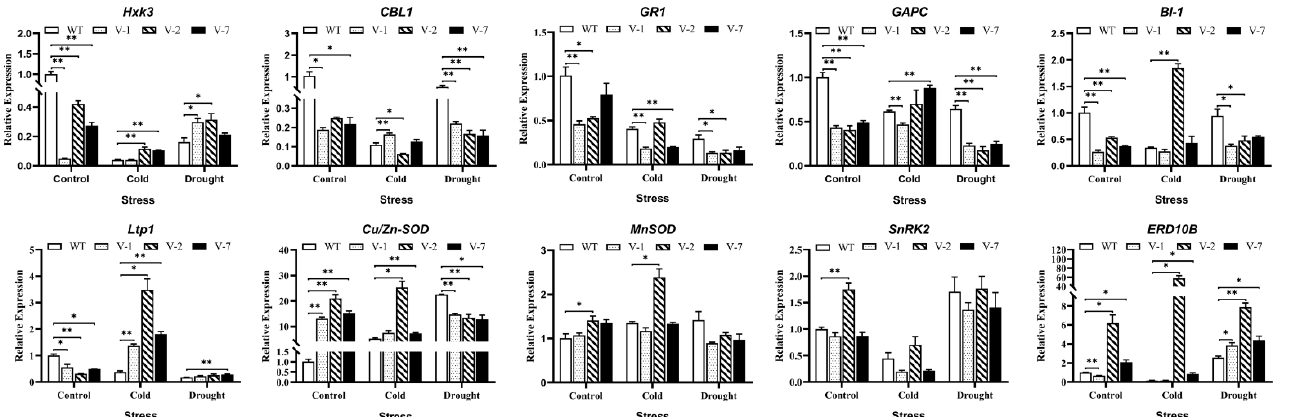
Figure 5. Expression of 10 stress-response genes in transgenic tobacco plants overexpressing MsVDAC under cold and drought stress. WT: wild type. V-1: line 1. V-2: line 2. V-7: line 7. The error bars represent the means ± SDs of three independent biological replicates. *, p < 0.05. **, p < 0.01.